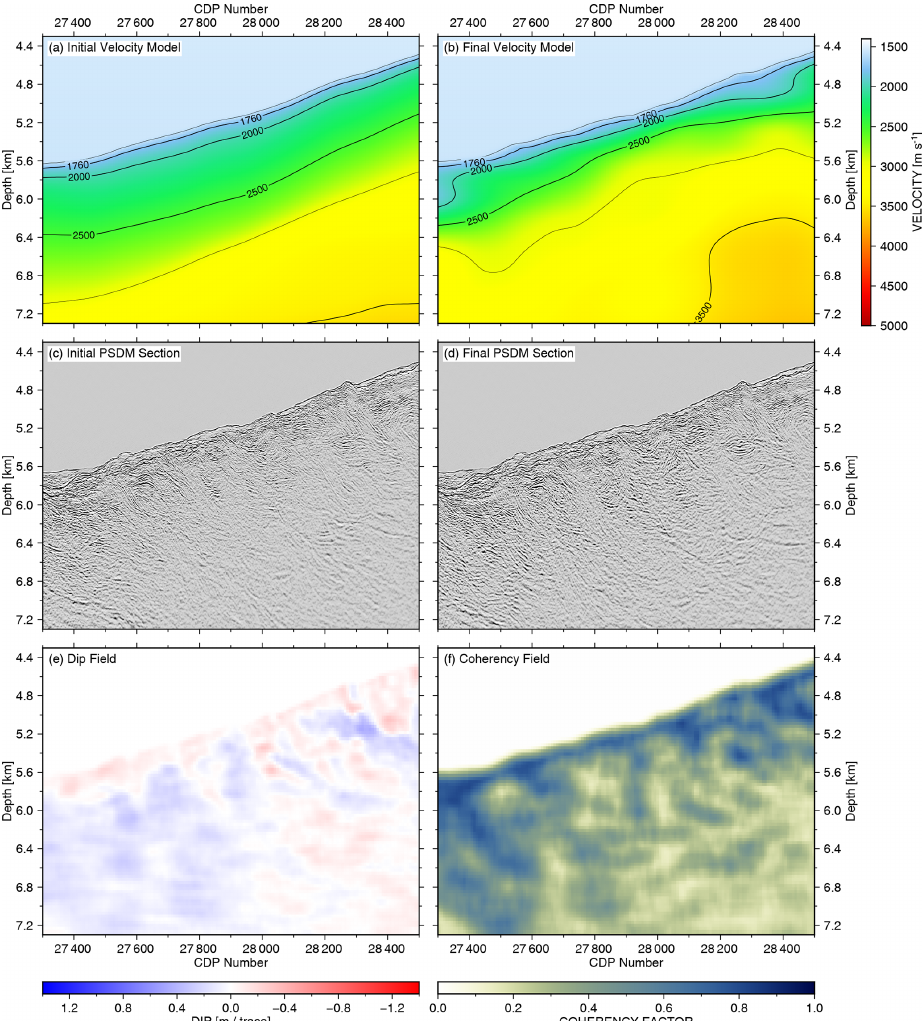
Figure 12. Depth tomography example C in Figs. 5 and 9a, with CDP ranging from 27200 to 28600. (a) Initial velocity model merged from velocity analysis and wide-angle refraction tomography. (b) Final velocity model after six iterations of NRM-based depth tomography and PSDM. (c) PSDM result based on the initial velocity model. (d) PSDM result based on the final velocity model. (e) Reflector dip field calculated from the final PSDM result. (f) Reflector coherency field calculated from the final PSDM result. Note that the vertical velocity gradient below the seafloor increased in the final velocity model (b) compared to the initial velocity model (a) with a result of stronger focusing of reflected energy by the PSDM (d) compared to (c)